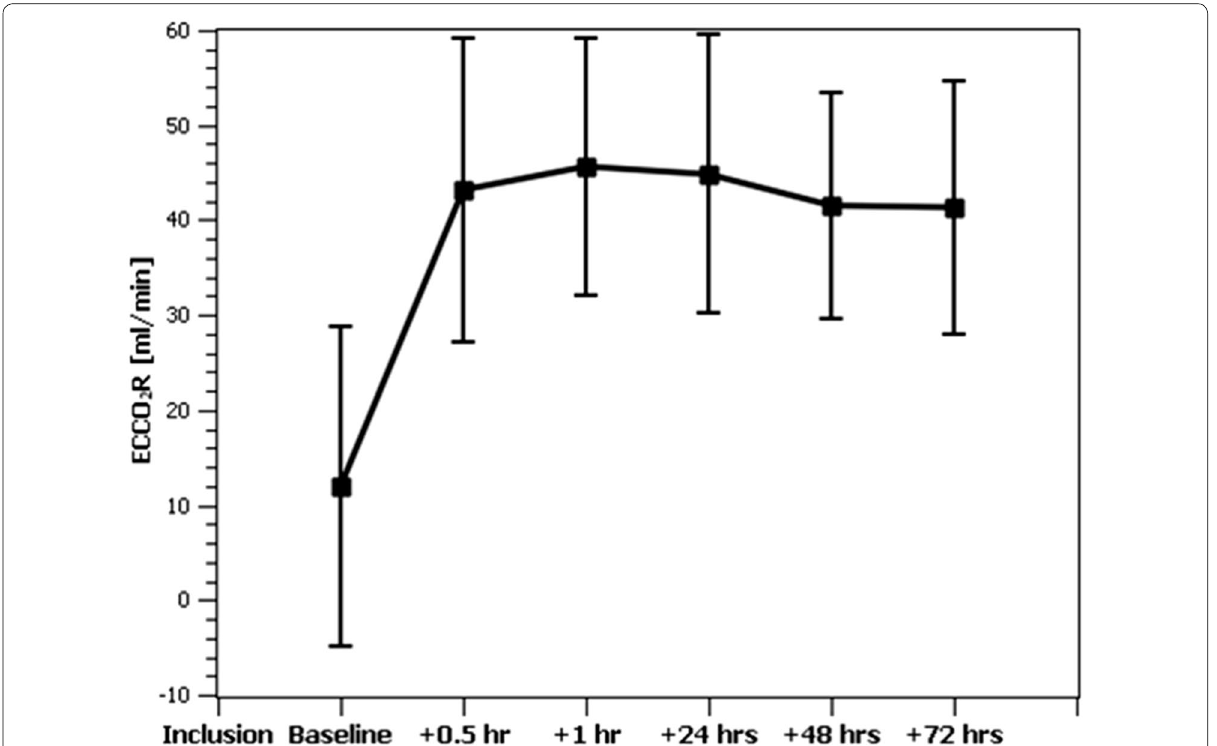
Fig. 1 Time course of ECCO 2 R over the study period. At baseline, the patient was connected to the extracorporeal circuit with the sweep gas flow over the membrane lung turned off